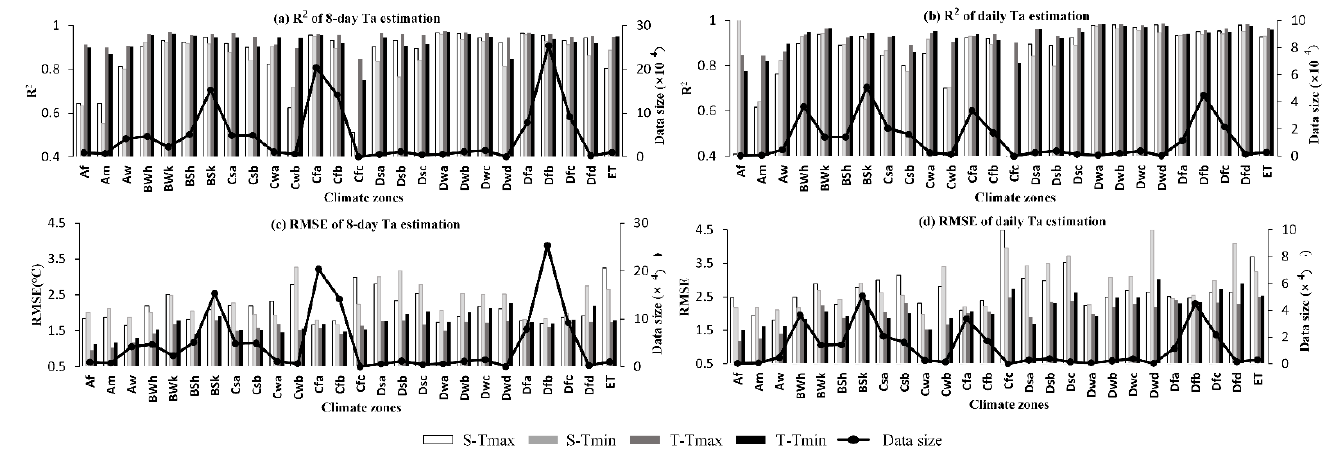
Figure 3. Estimation accuracy, i.e., R 2 and RMSE, of 8-day ( a , c ) and daily ( b , d ) Tmax and Tmin in both spatial and temporal experiments on a continental scale: Asia (AS), North America (NA), Eu- rope (EU), Africa (AF), South America (SA), Oceania (OA).